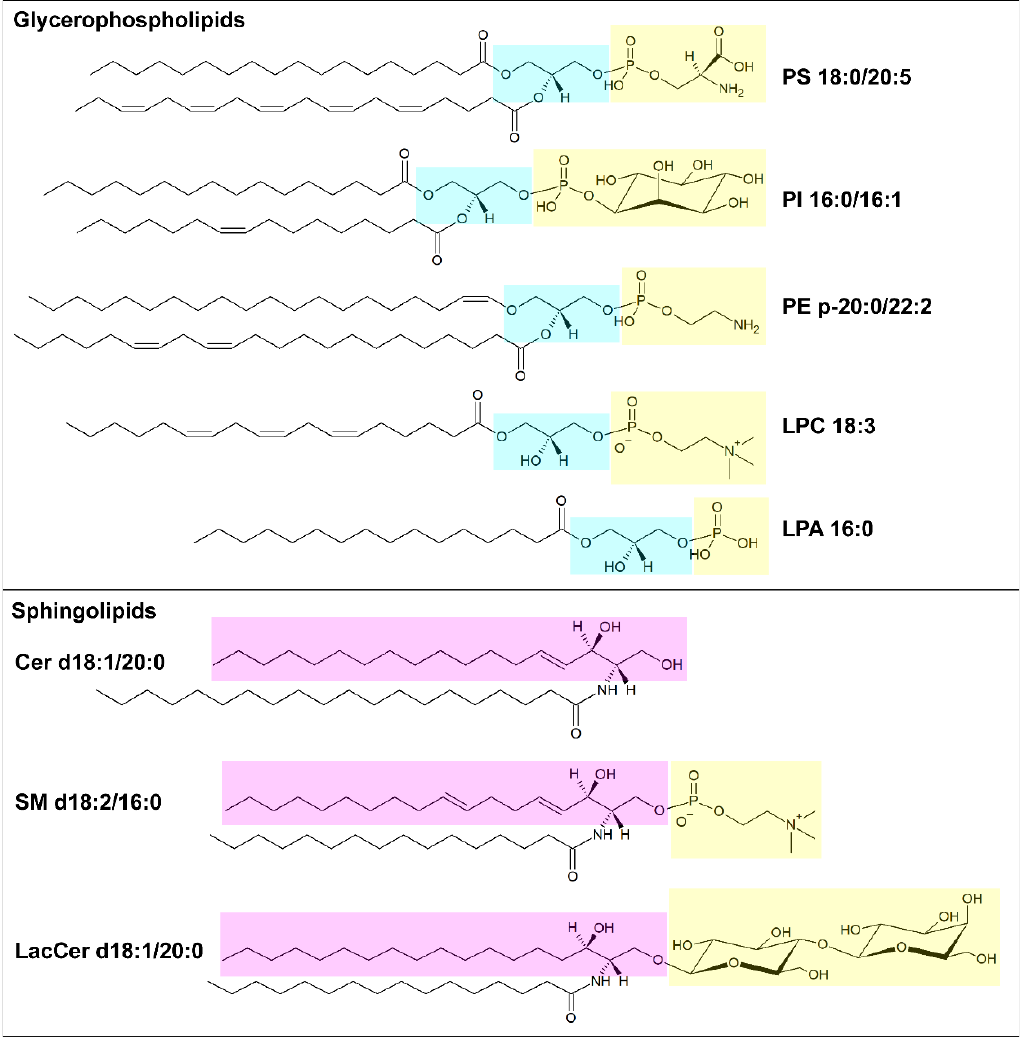
Figure 1. Schematic illustration of membrane lipids. In the upper box, example of glycerophospho- lipids: phosphatidylserine (PS) 18:0/20:5, phosphatidylinositol (PI) 16:0/16:1, alkenyl ether (plasmal- ogen) phosphatidylethanolamine (PE) p20:0/22:2, lysophosphatidylcholine (LPC) 18:3 and lyso- phosphatidic acid (LPA) 16:0. The glycerol moiety is marked in light blue, and the polar head is marked in yellow. In the lower box, examples of sphingolipids: ceramide (Cer) d18:1/20:0, sphingo- myelin (SM) d18:2/16:0 and lactosylceramide (LacCer) d18:1/20:0. The pink box highlights the long- chain base (LCB), sphingosine, and the yellow one highlights the polar head. Structures have been made using the Structure Drawing Tools available at Lipid Maps [15]. The de novo synthesis of FAs is low in normal adult cells (except for lipogenic tissues, such as liver and adipose tissue). In contrast, increased lipogenesis is well documented in cancer cells, making them less dependent on the availability of nutrients and enabling the building of a cell membrane enriched in phospholipids containing oxidative damage-re- sistant saturated FAs [16]. The biosynthesis of FAs begins with the carboxylation of cyto- solic acetyl-CoA by acetyl-CoA carboxylase (ACC) to produce malonyl-CoA, which be- comes the substrate of FA synthase (FASN), forming palmitic acid (C16:0). Palmitate can be further elongated by FA elongases (ELOVL1-7) and desaturated by stearoyl-CoA de- saturases (SCD) and FA desaturases (FADS1-3), to generate a cellular pool of non-essential FAs, such as palmitoleate (C16:1), stearate (C18:0) and oleate (C18:1). All three enzyme families involved in FA synthesis (ACC, FASN, SCD) are frequently up-regulated in sev- eral cancer types, including glioblastoma, breast, ovarian, lung, prostate and liver cancer; furthermore, their expression correlates with poorer prognosis and high cancer grade [7].